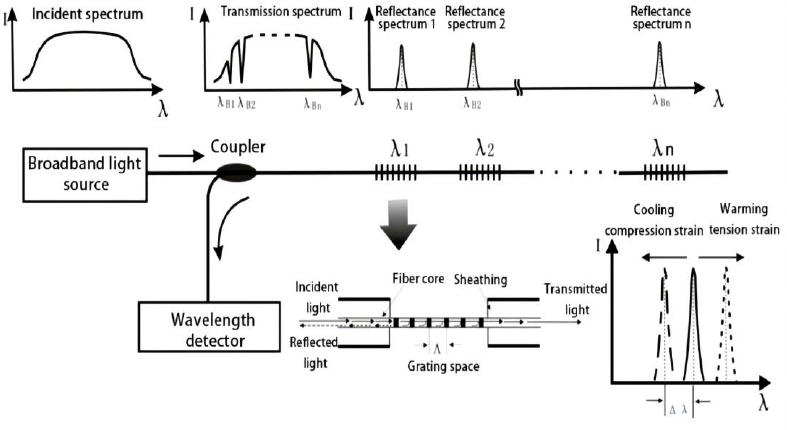
Figure 2. Testing principle of FBG strain sensor.